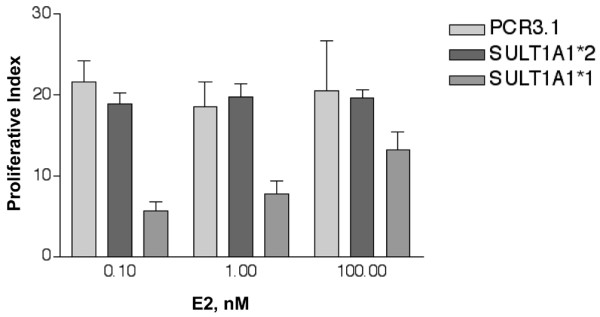
Proliferative response of MCF-7 cells overexpressing different SULT1A1 allozymes. MCF-7 cells overexpressing SULT1A1*2 proliferate faster in response to 17β-estradiol (E2) than cells overexpressing SULT1A1*1 (P = 0.002). Cells stably expressing equal levels of SULT1A1 mRNA (SULT1A1*1 or SULT1A1*2) were selected for study. Cells were plated onto 96-well plates and, in triplicate, treated with increasing concentrations of E2 (0, 0.1, 1 and 100 nM) in charcoal-stripped media. Data were corrected for proliferation in the absence of E2 to calculate the proliferative index. Data for 'pCR3.1' cells were generated in a MCF-7 control cell line mock-transfected with the empty pCR3.1 vector.